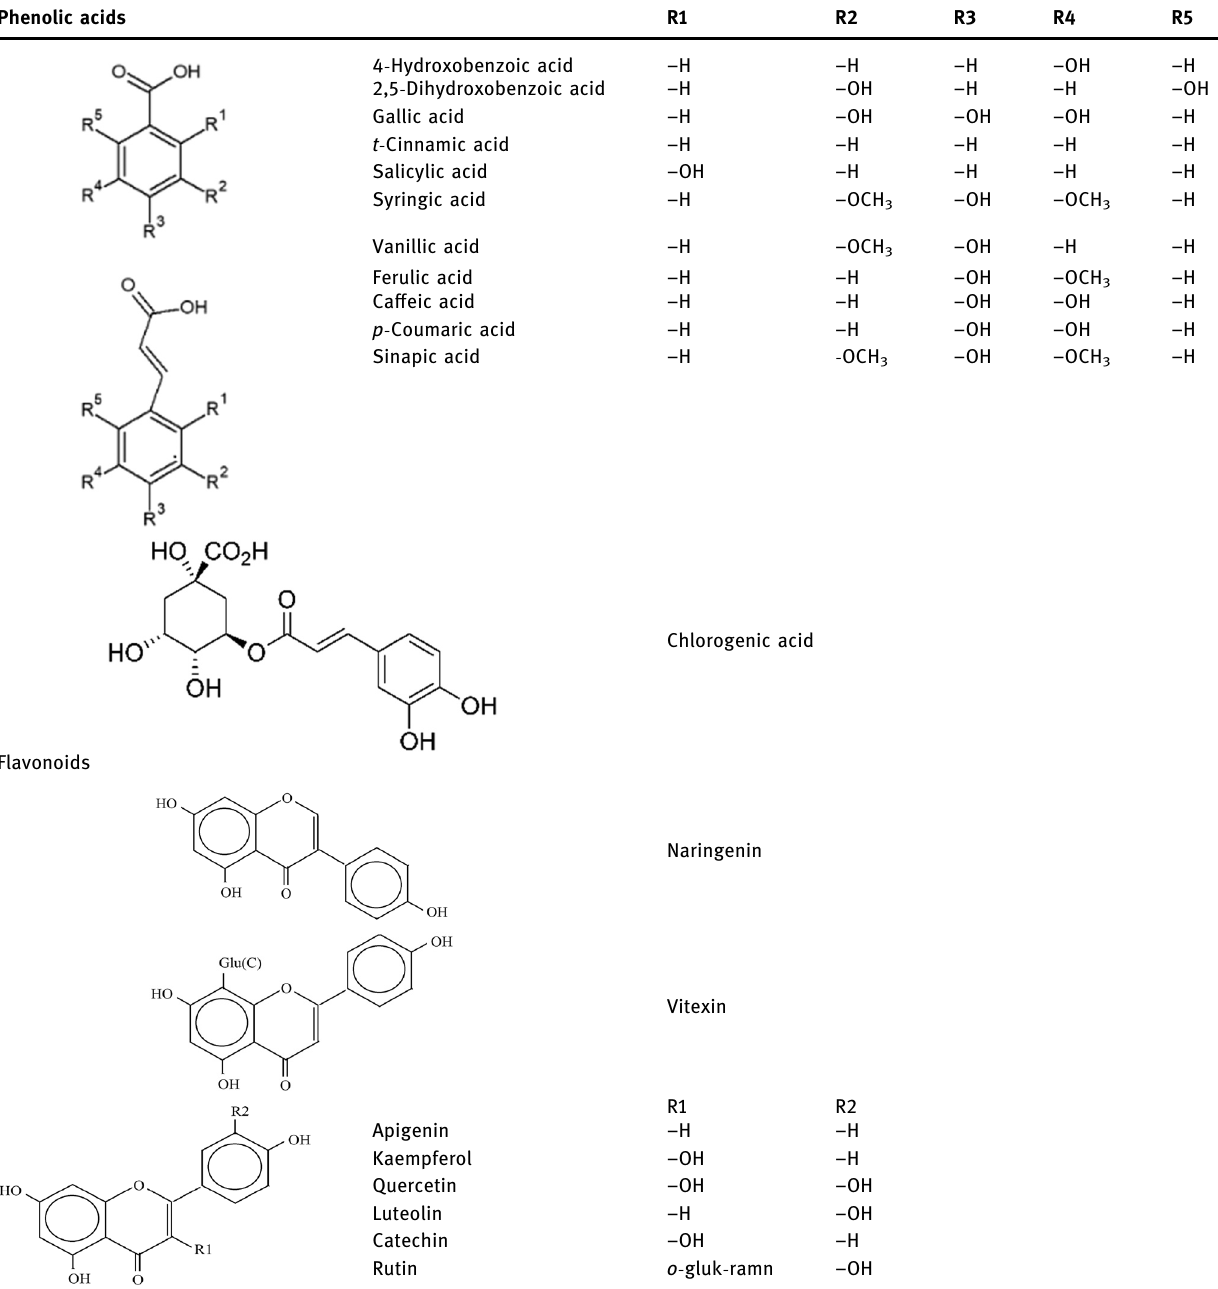
Table 3: Chemical structure of compounds analyzed Phenolic